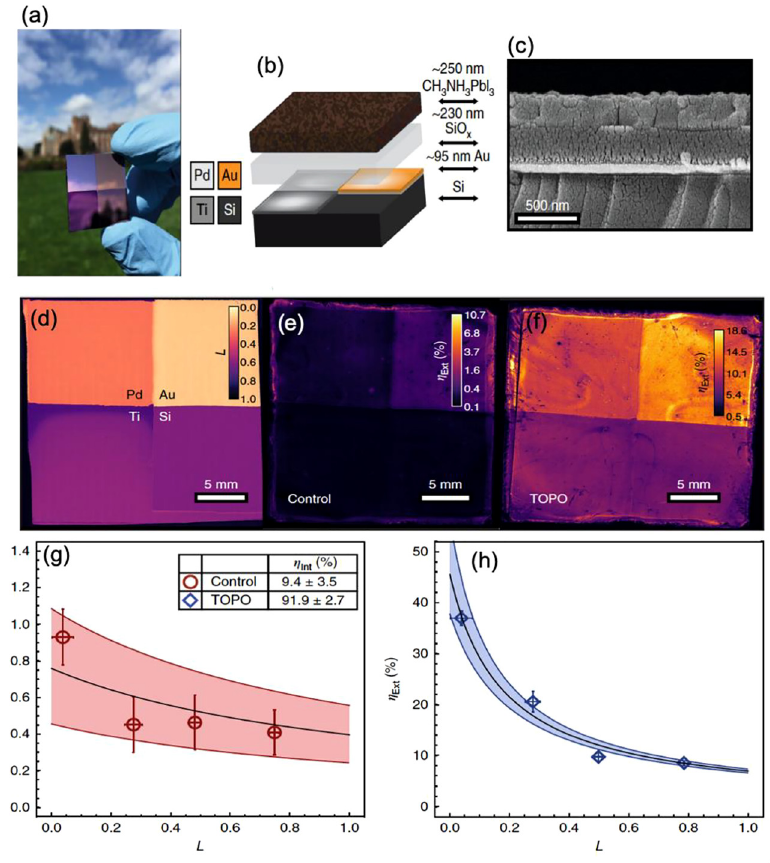
Figure 7: (a) Photograph of the image of multimetal back reflector substrate. (b) Schematic diagram of a perovskite film deposited on multimetal rear reflector for determining the internal quantum efficiency. (c) Cross-section of scanning electron microscopy (SEM) image of a perovskite/SiO x /Au/Si sample. Measurement of internal and external luminescence ef fi ciency of surface passivated perovskite fi lm; (d) Spatialdistributionmapofopticallossfactors( L =1-Re fl ectivity)withinthequadrants(Pd,Au,Ti,Si)ofthebacksubstrate.Spatialdistribution map of external luminescence quantum ef fi ciency ( η ext ) of (e) control and (f) TOPO-treated perovskite fi lm deposited on the multimetal back re fl ector.Duetothepassivatedsurface(TOPOtreated), η ext improvesacrosstheentiresample.(g),(h) η ext asfunctionofLforcontrolandTOPO passivated fi lm.Theerrorbarsdepict95%con fi denceintervalsduetospatialheterogeneity,whereastheblacklinesarenonlinearregression fi ts.(Theshadedregionsrepresent95%con fi denceintervalsoftheregression fi ts).WecanseetheadvantageoftheTOPOpassivated fi lm, η and η ext reached a value of ∼ 91.0 and ∼ 36.4%, respectively. Figure (a) – (h) are taken with permission from Ref.